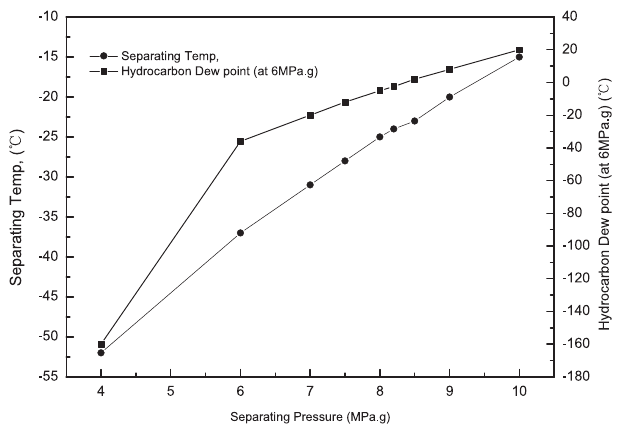
Fig. 4. The relation between the dew point and the separating (refrigeration)